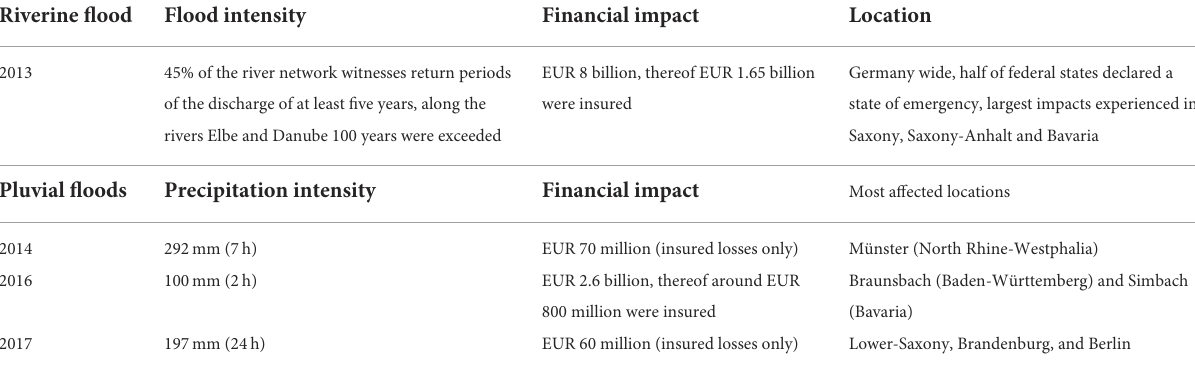
TABLE 1 Overview of the hydrological and financial impacts of large floods in Germany between 2013 and